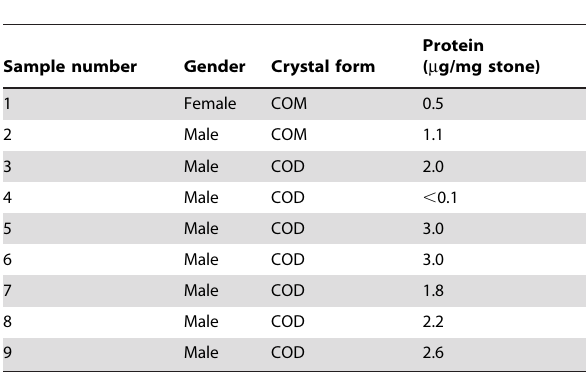
Table 1. Kidney stone samples analyzed in this study.